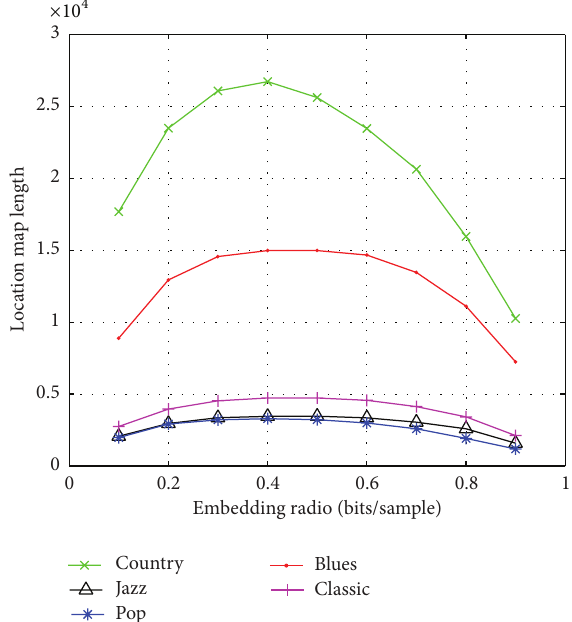
Figure 8: The embedding capacity versus compressed location map length curve of five types audio quality curve of five types